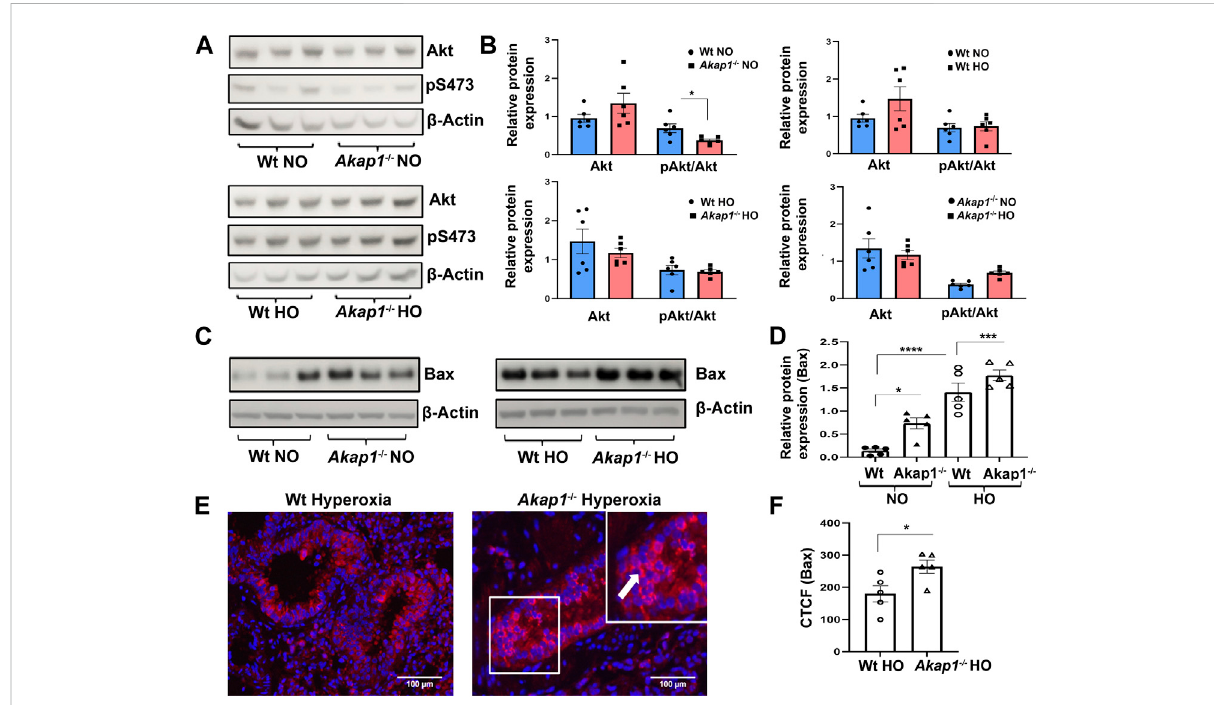
FIGURE 6 AKAP1 loss induced Akt inactivation and increased Bax expression under hyperoxia. (A) Representative Western blot analysis of total Akt and phosphorylatedAkt(pS473)inthelunglysatesderivedfrom Wt and Akap1 − / − miceexposedtonormoxiaorhyperoxia. (B) TotalAktandpAkt/TotalAkt quantitated after normalization with β -Actin control. Data represented as mean ± SEM. n = 5 mice per group. Two-tailed unpaired Student ’ s t-test. * p < 0.05 Akap1 − / − normoxia to Wt normoxia. *** p < 0.001 Akap1 − / − normoxia versus Akap1 − / − hyperoxia. (C) Representative Western blot analysis of Bax in the lung lysates from Wt and Akap1 − / − mice exposed to normoxia or hyperoxia. (D) Quantitation of Bax expression after normalization with β -Actin control. Data presented as mean ± S.E.M. n = 5 mice per group. Two-tailed unpaired Student ’ s t-test. * p < 0.05 Akap1 − / − normoxia versus Wt normoxia, **** p < 0.0001 Wt normoxia versus Wt hyperoxia and *** p < 0.001 Akap1 − / − hyperoxia versus Akap1 − / − normoxia. (E) Representative IF image of Bax expression in the lung section of Wt and Akap1 − / − mice exposed to hyperoxia. White arrow shows positive Bax immunoreactivity.NucleistainedwithDAPI(blue).Magni fi cation:×400,scalebar:50 μ m. (F) QuantitativeanalysisofBaxexpressionisrepresentedas CTCF. Bax immunoreactivity in the lung sections of Akap1 − / − hyperoxia versus Wt hyperoxia. Data represented as mean ± SEM. n = 5 mice